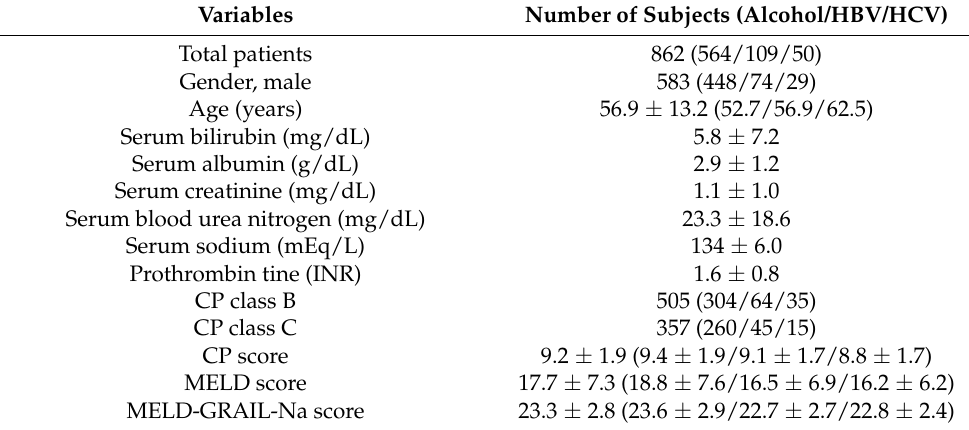
Table 3. Baseline characteristics of enrolled patients (CP classes B and